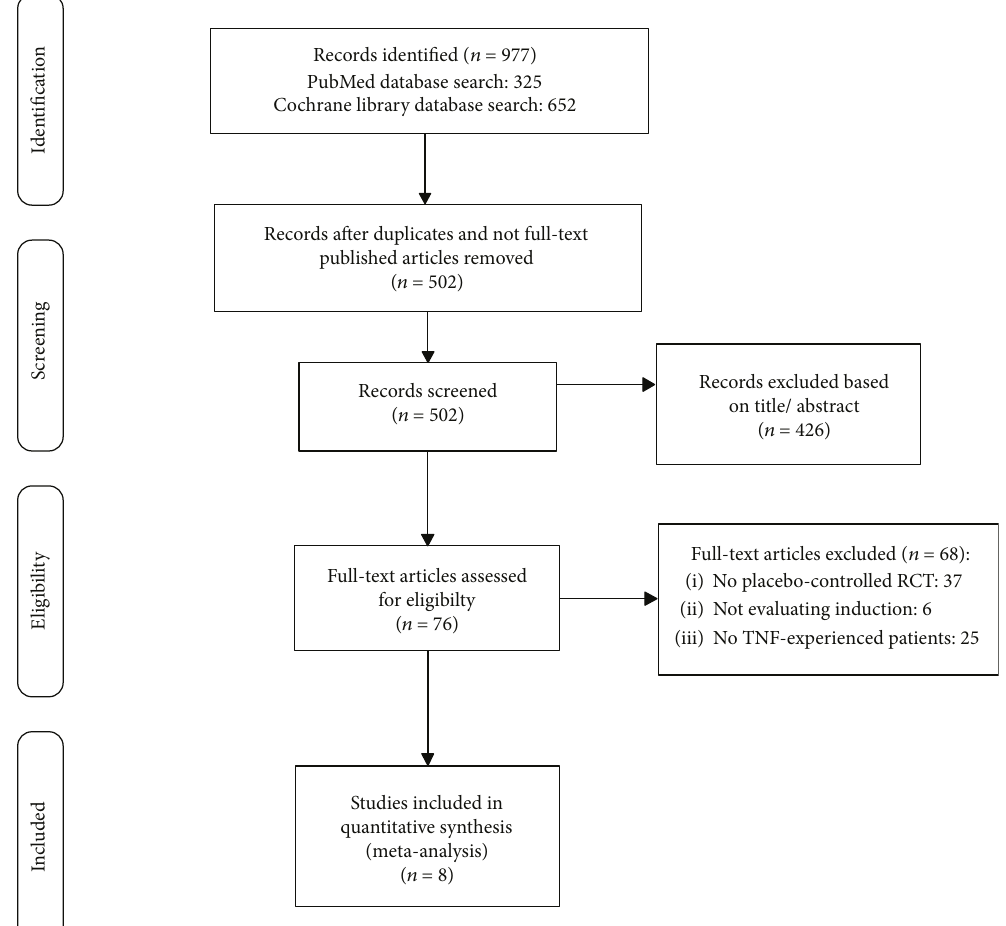
Figure 1: Summary of evidence search and selection for induction of response and remission in anti-TNF-experienced CD